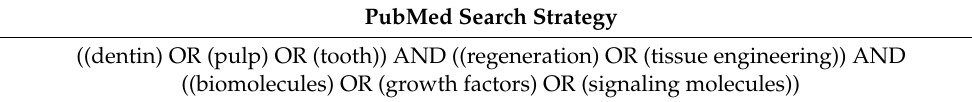
Table 1. Terms for database search strategy.